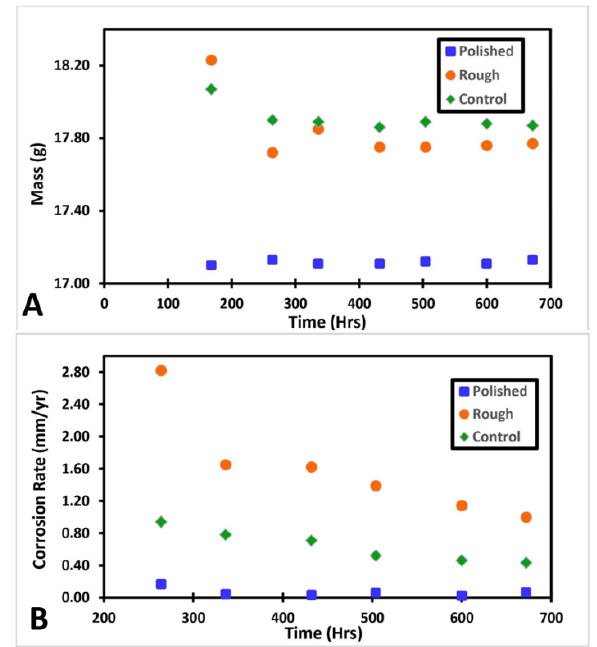
Figure 2. ( A ) Shows the change in mass for each sample, ( B ) shows the corrosion rate for each sample at each time period. The control and roughened samples had similar trends in mass loss. Both samples had a decrease in mass followed by a plateau. Both samples plateaued around 350 h. The roughened sample had a more dramatic mass change. The polished sample remained approximately constant throughout the experiment. The same relative intensities are visible for each samples corrosion rate.